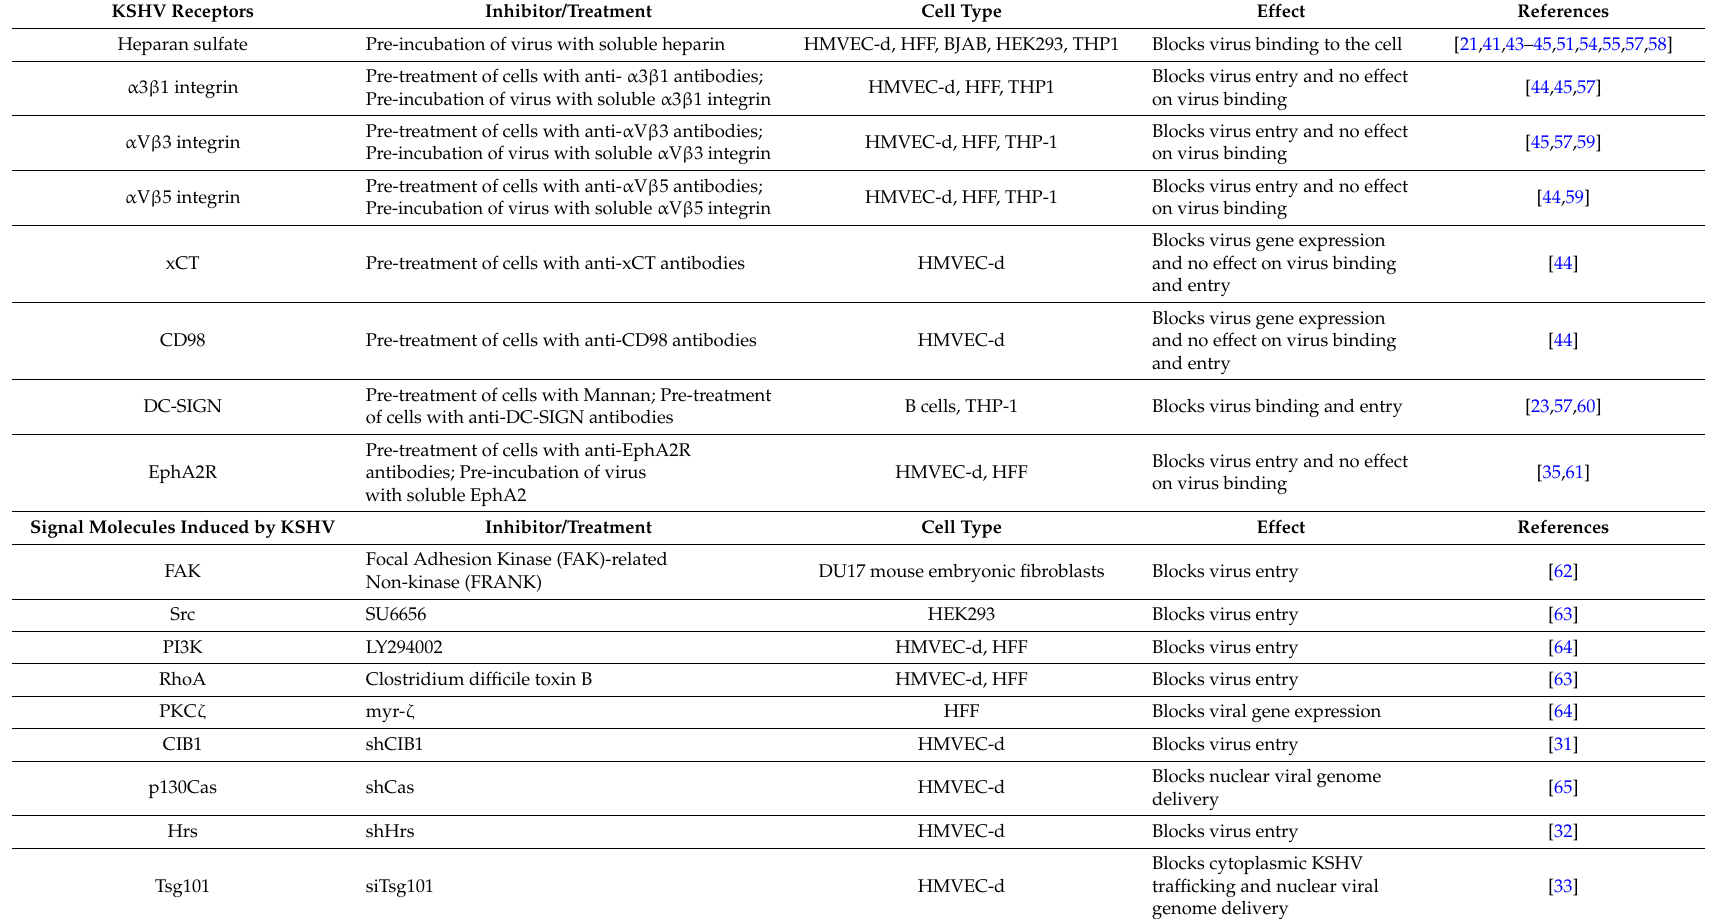
Table 1. Summary of cell surface receptors utilized by KSHV and induced signal molecules, the methods used to block them and their effects on KSHV entry and